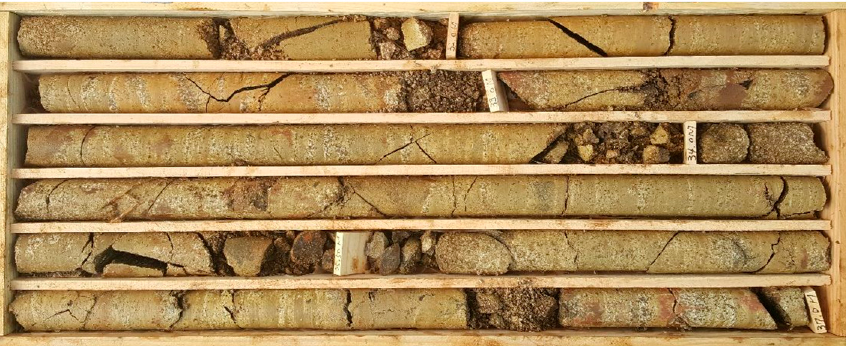
Figure 4. Retrieved sample of grade IV and V granite at G site. Table 1. Applied chemical weathering indices. ↑ : increase, ↓ : decrease.